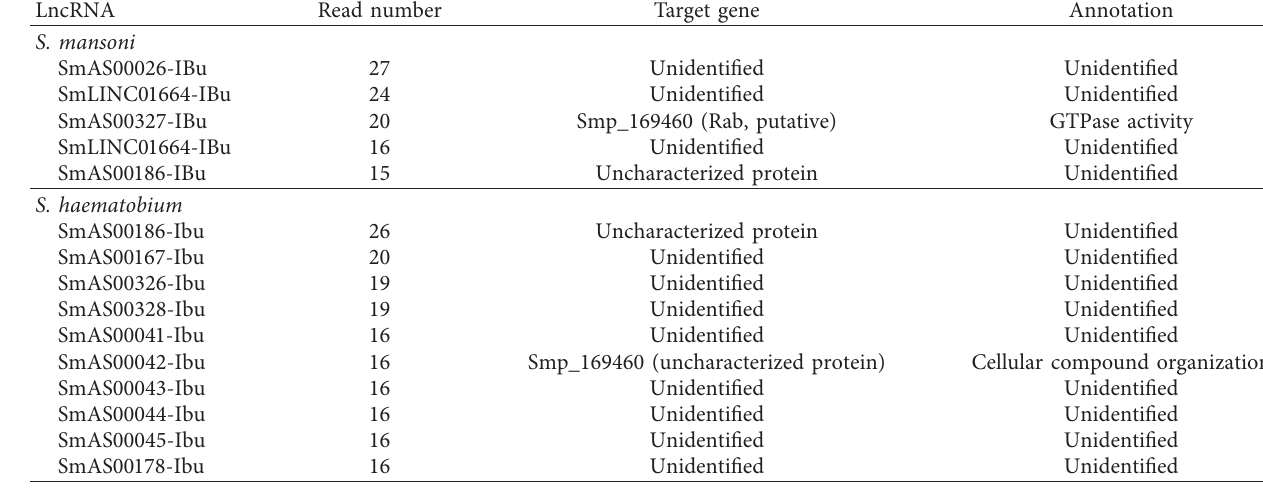
Table 1: Long noncoding RNA transcripts showing high read numbers in S. mansoni and S. haematobium . LncRNA